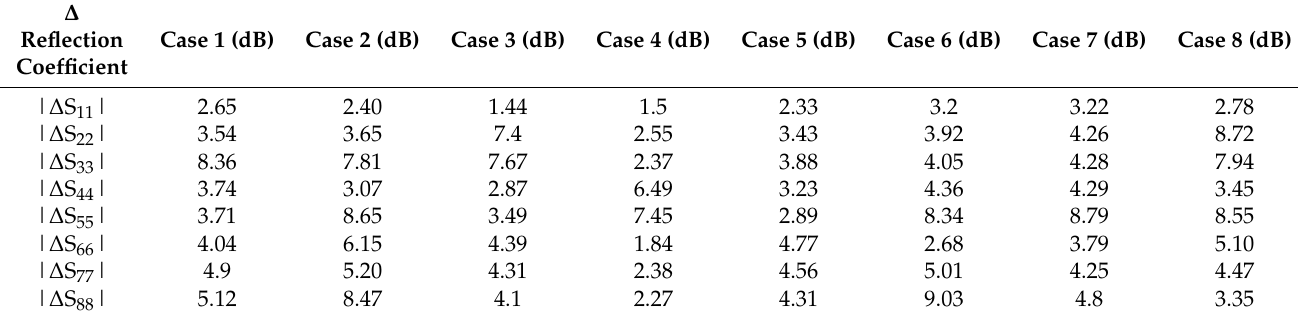
Table 4. Difference in reflection coefficient values between phantoms with and without tumor for each superficial